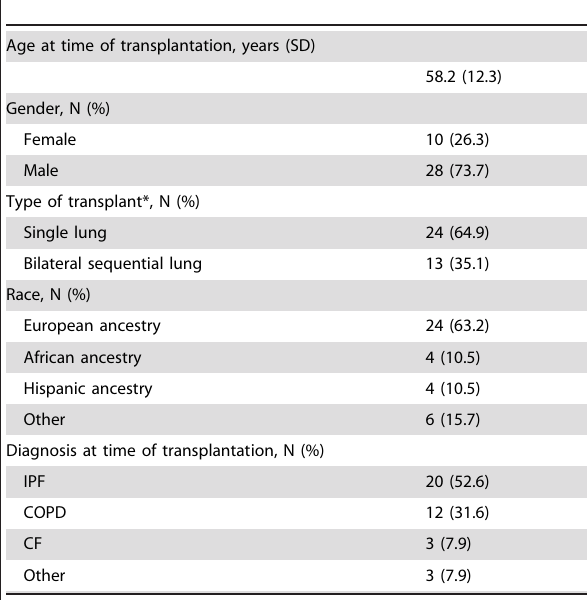
Table 1. Demographic characteristics of 38 subjects in